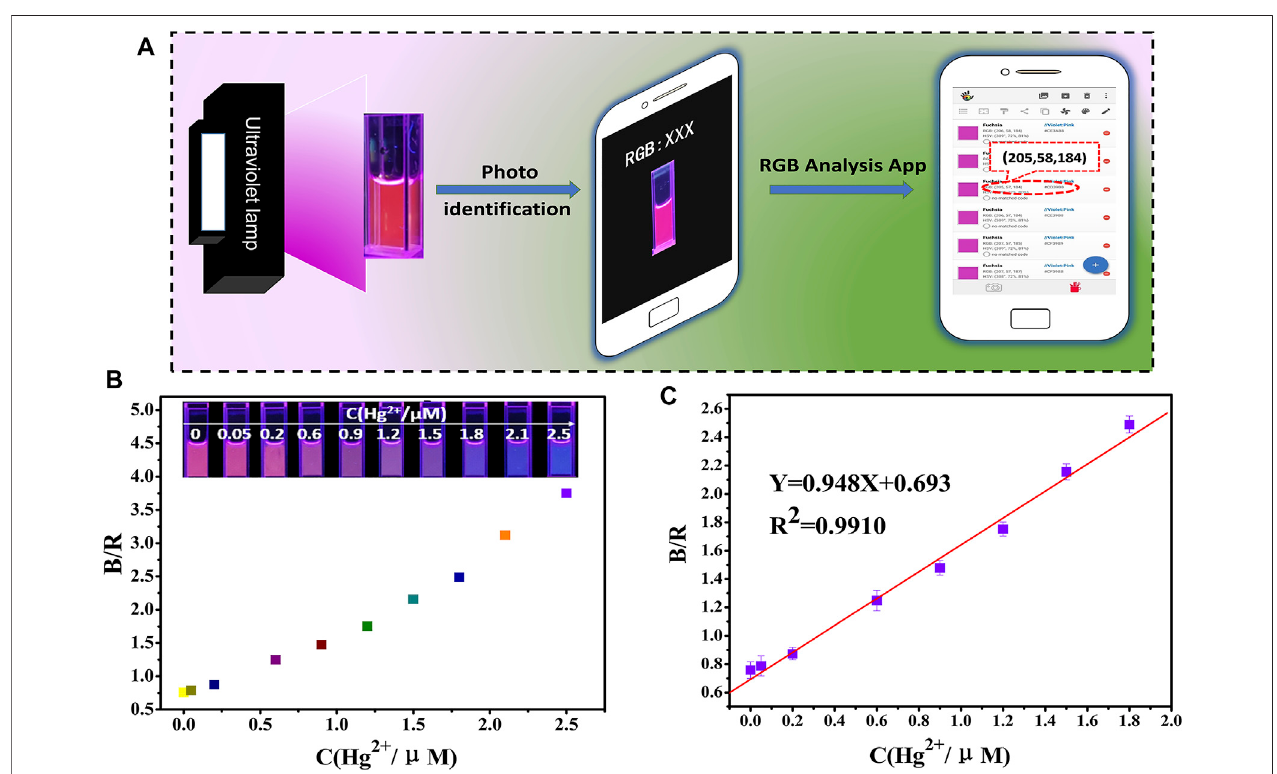
FIGURE 3 | (A) Schematic drawing of the detection of Hg 2+ using a smartphone; RGB analysis of the generated images via a color recognizer application; (B,C) detection of Hg 2+ by the fl uorescence probe solution combined with a smartphone.